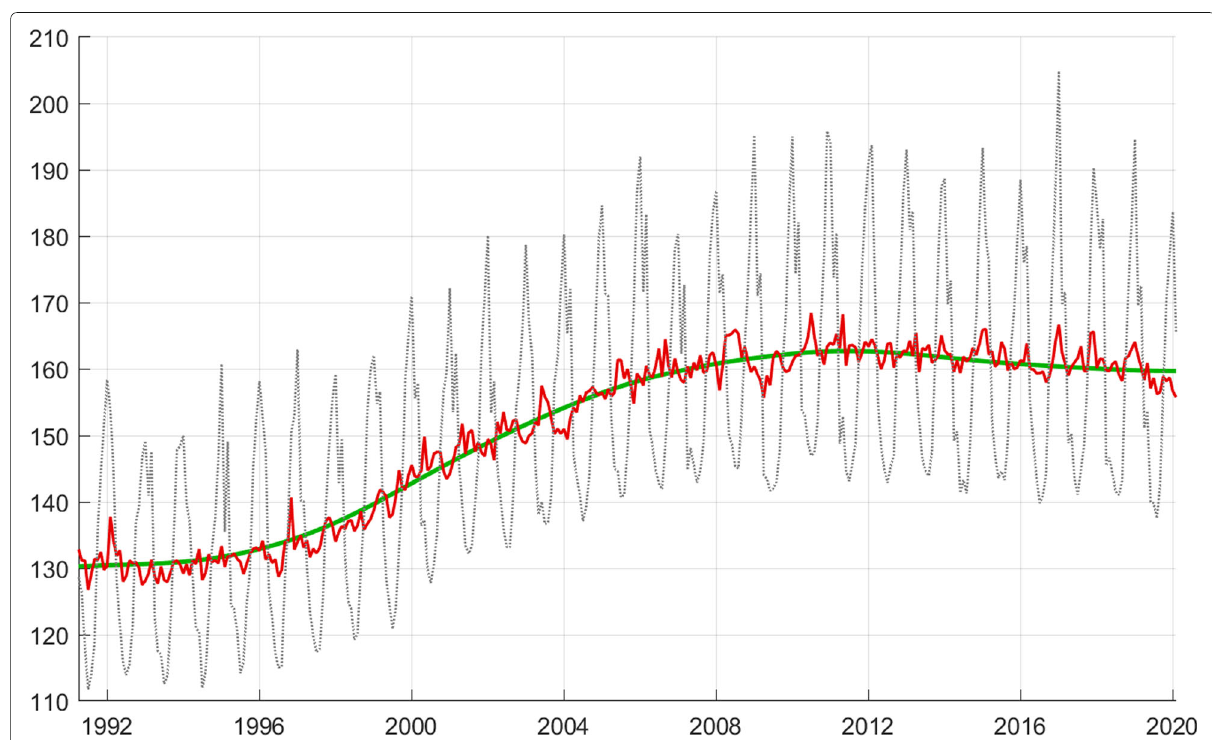
Fig. 6 Monthly data ( Y ), adjusted series ( Z ), and HP trend ( Y ∗ ) [measured in GWh]. The original data are divided by 30 to make them roughly comparable to the daily